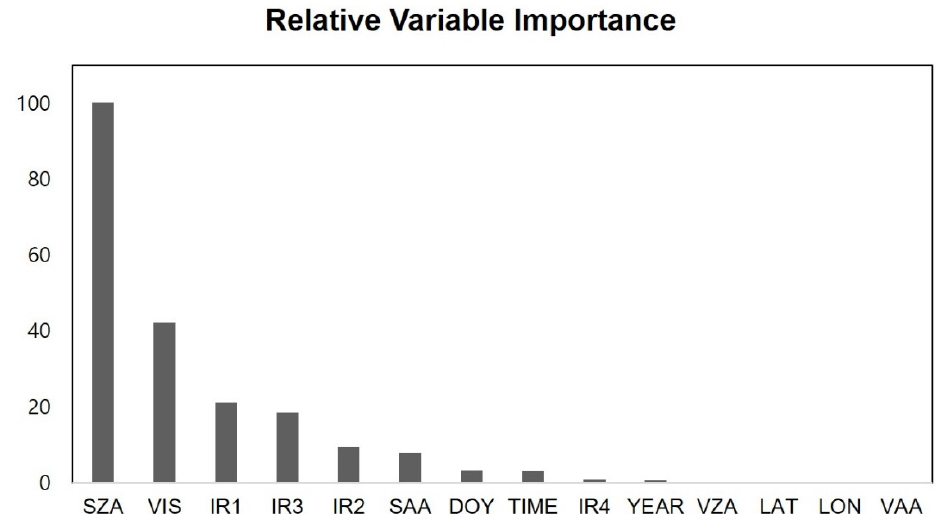
Figure 5. Relative variable importance determined using RF analysis for solar zenith angle (SZA), visible spectral band (VIS), infrared bands IR1–4, solar azimuth angle (SAA), day of year (DOY), time, year, viewing zenith angle (VZA), viewing azimuth angle (VAA), latitude (LAT), and longitude (LON).